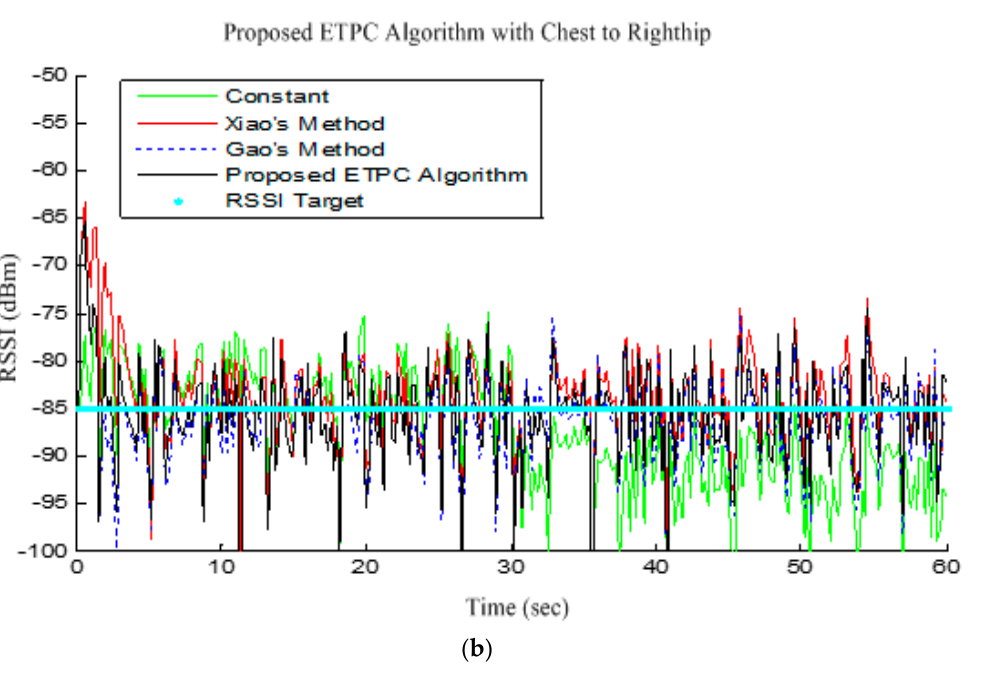
Figure 13. Transmission power level and RSSI in chest to Righthip: ( a ) Transmission power level; ( b ) RSSI samples of each packet.